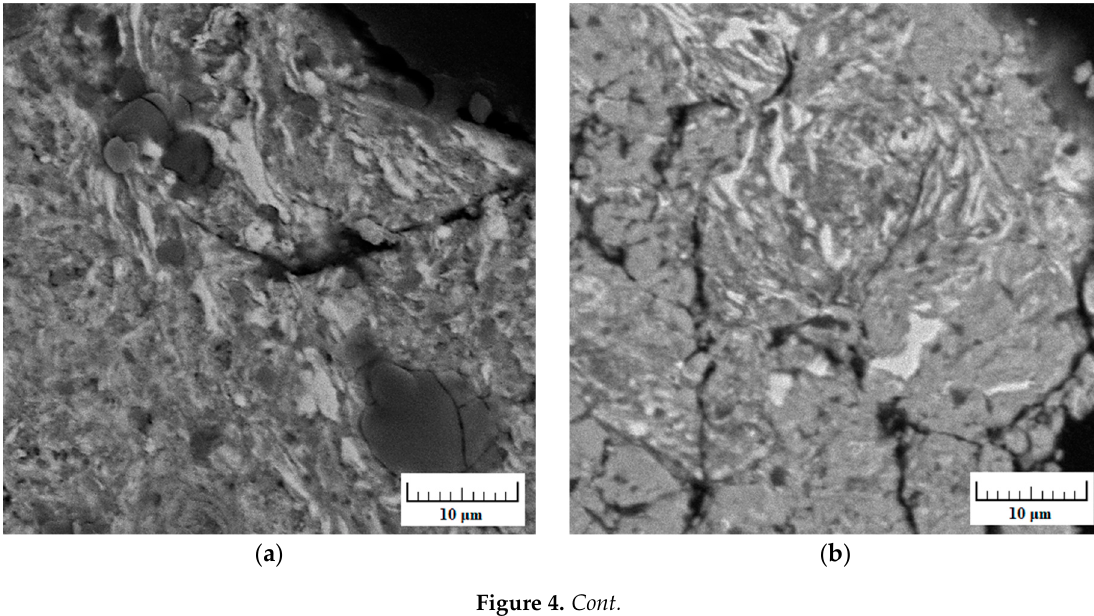
Table 4. Lattice parameter a ( × 10 − 10 m) of the FeAl and Fe 3 Si phases vs. milling time.